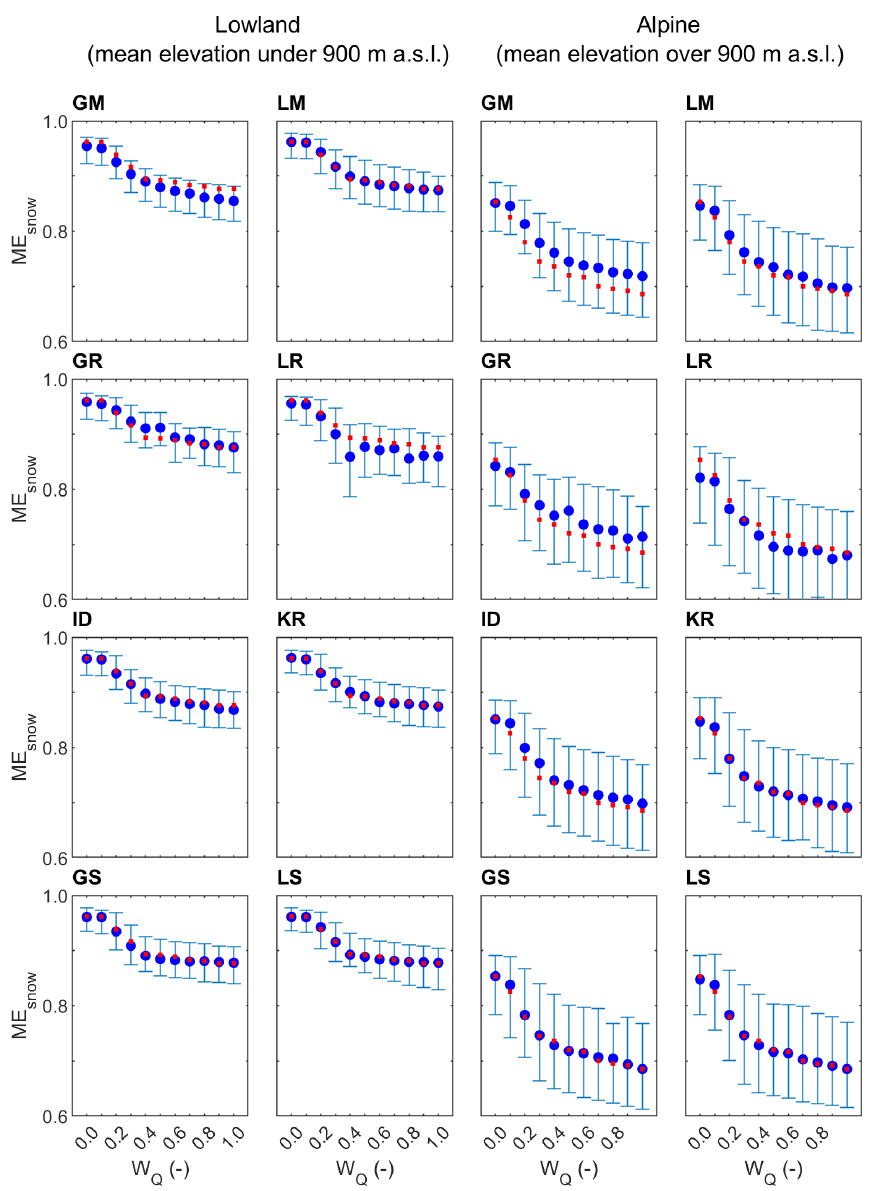
Figure 6. Median and regional scatter of the leave-one-out snow model efficiency (Eq. 9) obtained by eight groups of parameter transfer methods and 11 calibration weights for lowland (94) and alpine (119) catchments in the calibration (2000–2010; blue symbols) period. Blue circles represent the median and whiskers the 25% and 75% quantiles of the leave-one-out efficiency. Red symbols show the median of the at-site snow model